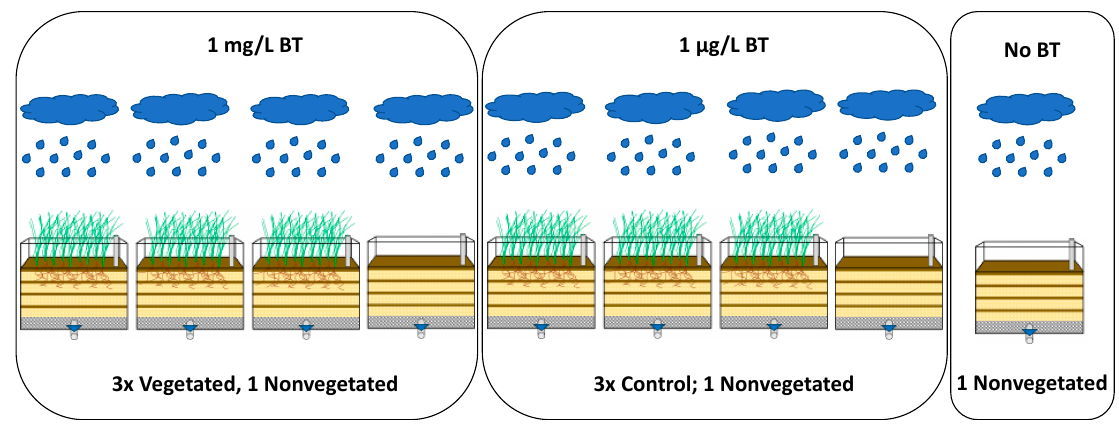
Figure A1. Diagram showing nine total biofilter mesocosms used in the preliminary experiment, of which the three vegetated mesocosms and one nonvegetated mesocosm received stormwater spiked with 1 mg/L, the three control mesocosms and one nonvegetated mesocosm received stormwater spiked with 1 µg/L, and one nonvegetated mesocosm did not receive BT.